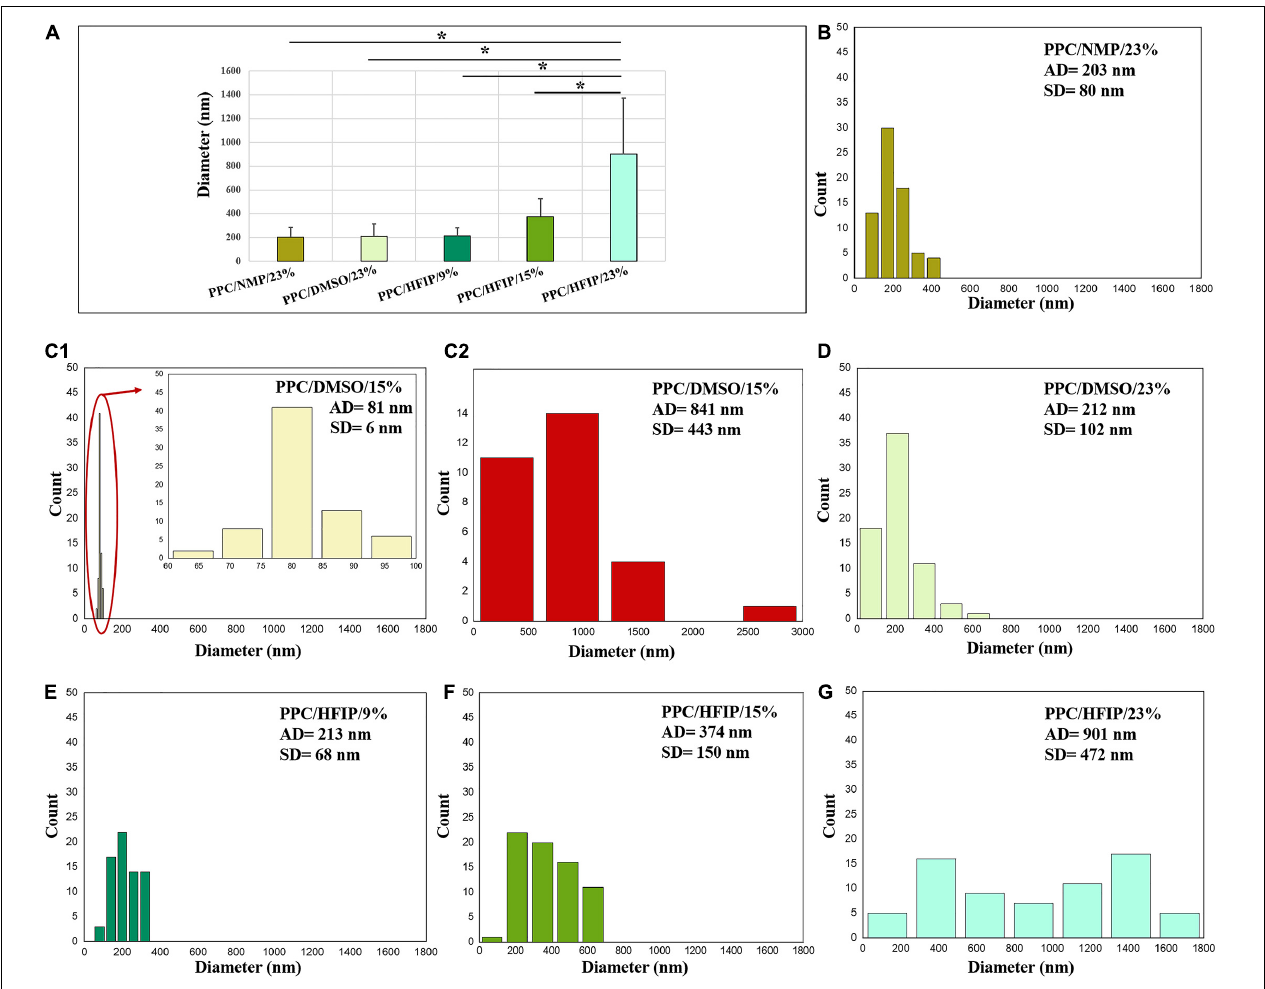
FIGURE 2 | Diameter distribution of electrospun PPC nanofibers: (A) Comparison of five nanofibrous sample, (B) PPC/NMP/23%, (C 1 ) PPC/DMSO/15% (nanofibers),